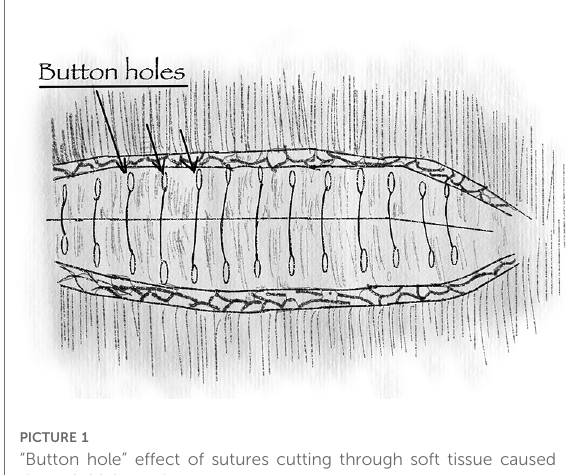
PICTURE 1 “ Button hole ” effect of sutures cutting through soft tissue caused through high